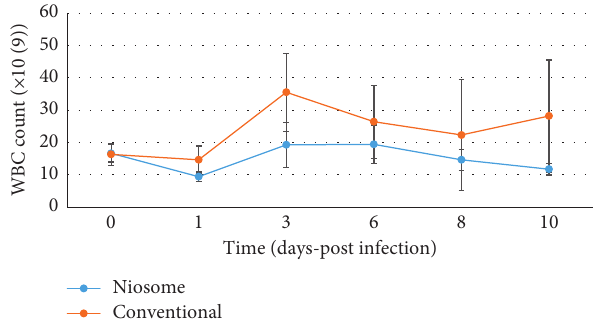
Figure 5: Graph showing White blood cell count in Sprague Dawley rats after infection with Pseudomonas aeruginosa and treatment with niosome and conventional levofloxacin ( p < 0 .